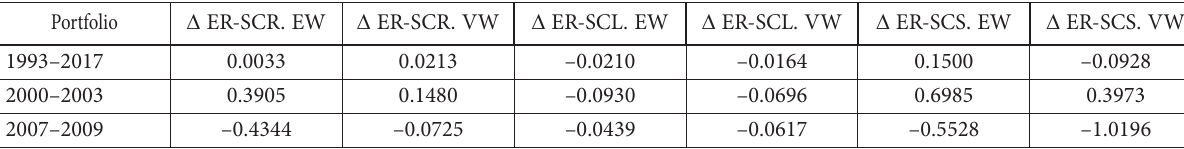
Table 2. T-test for the difference in average returns